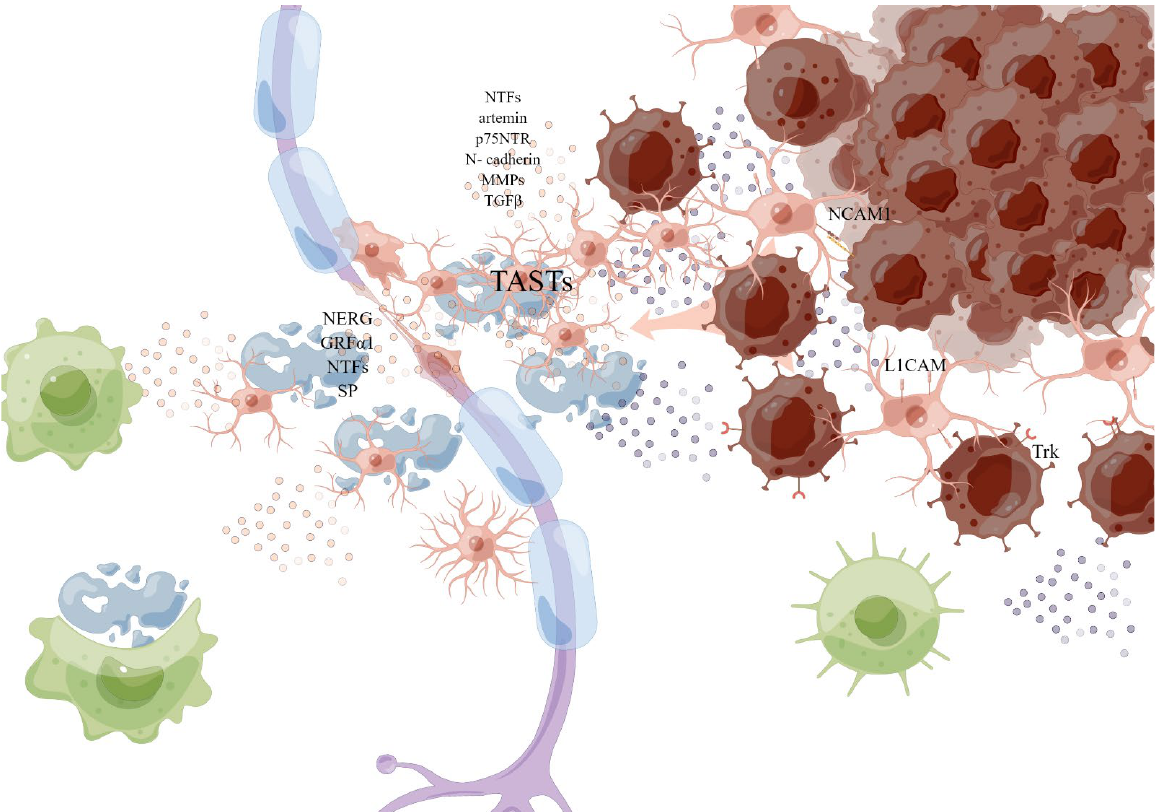
Figure 4. Schwann cell. The myelinated SCs are dedifferentiated into “repair SCs” (rSCs) with a demyelinating phenotype when it is damaged or invaded. By producing a variety of neurotrophic factors and cell surface proteins to interact with cancer cells, including GDNF, artemin and BDNF, p75 neurotrophic factor receptor (p75NTR), TGF β , and N-cadherin, remodeling the matrix to help the migration of cancer cells, and releasing pro-inflammatory mediators: TGF β , prostaglandin E, to change the local signaling environment, the injured SCs can induce macrophages to synergistically remove myelin debris, and produce (TASTs) as active scaffolds to guide axonogenesis or cancer invasion. This picture is drawn by Figdraw